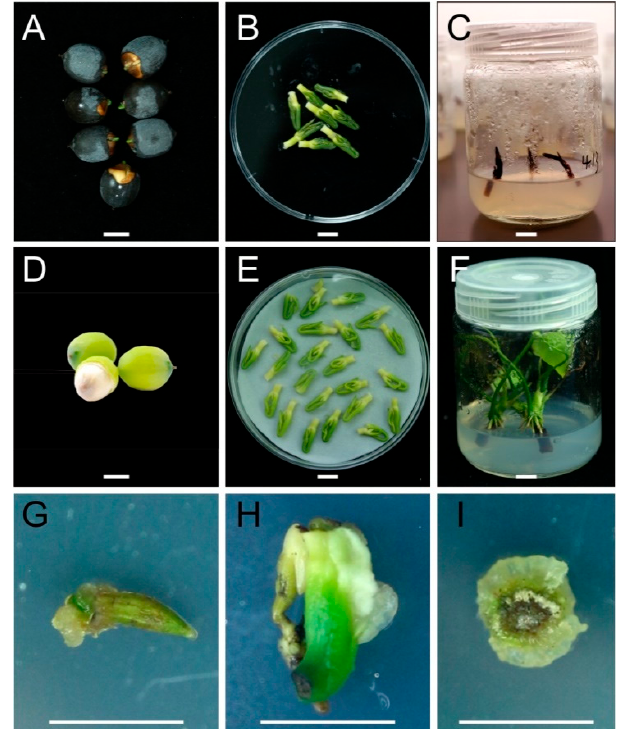
Figure 4. Regeneration of aseptic lotus seedlings for callus induction in lotus genotype “WBG_S1.” ( A ) Stored mature lotus seeds with part of episperm removed. ( B ) Embryos taken from mature lotus seeds. ( C ) An example of mature embryos that died during culture. ( D ) Immature seeds at 15 days after pollination. ( E ) Immature embryos taken from lotus seeds 15 days after pollination. ( F ) Aseptic seedlings developed from immature embryo cultures. ( G , H , I ) Callus induced from leaf sections, epicotyl-petile complex sections and epicotyl sections of aseptic seedlings respectively. Bars indicate the length of 1 cm.